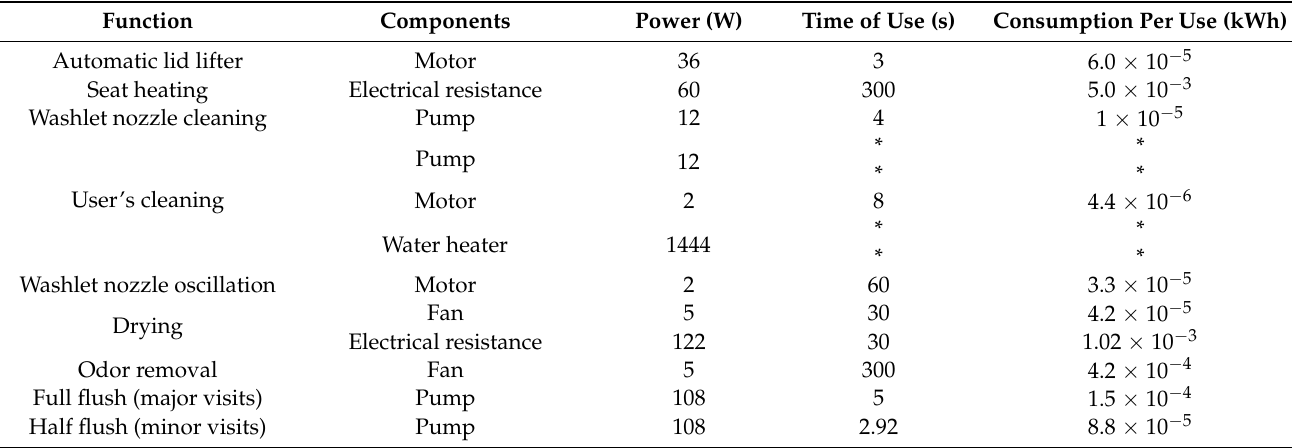
Table 3. WashOne electricity use per function per visit (major or minor). Source: Developed by the authors using data collected by the author affiliated with OLI and from the literature.